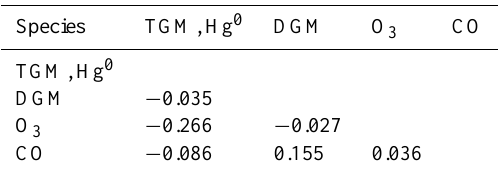
Table 4. Over-all correlation matrix of trace gases and